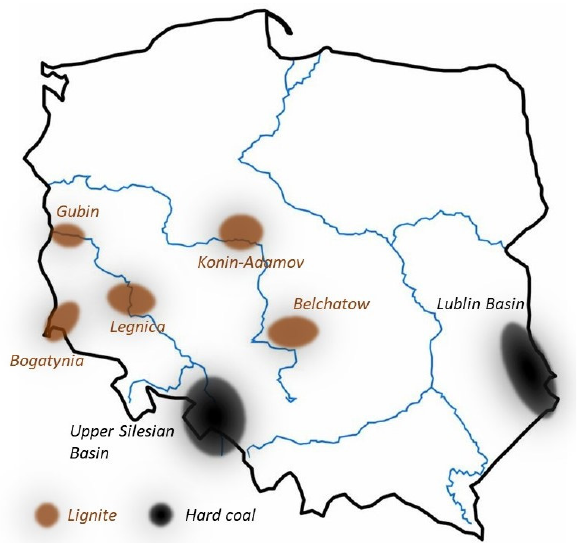
Figure 2. Coal regions in Poland (own elaboration, based on: https://euracoal.eu/, accessed on 2 September 2022).